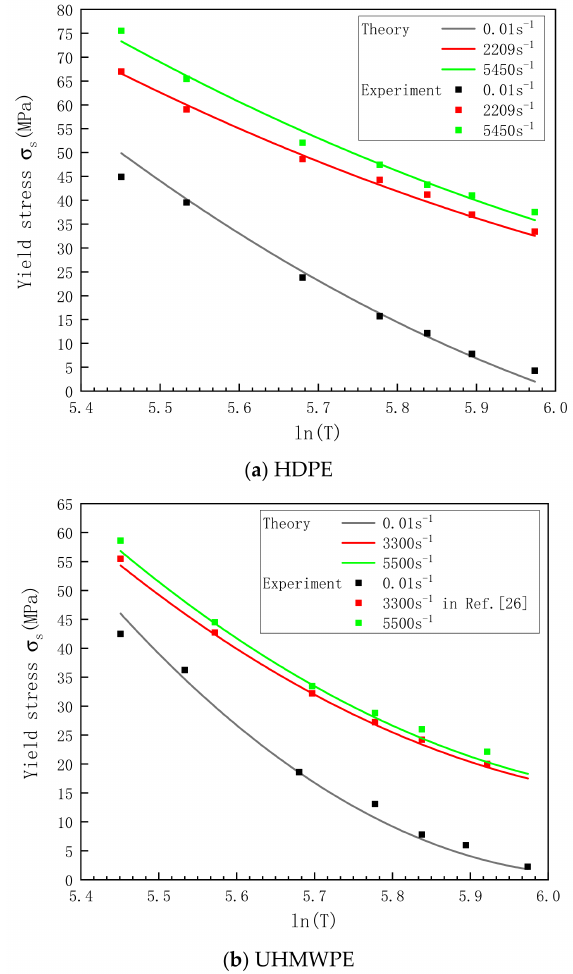
Figure 11. Relationship between the yield stress and temperature for ( a ) HDPE and ( b ) UHMWPE at different strain